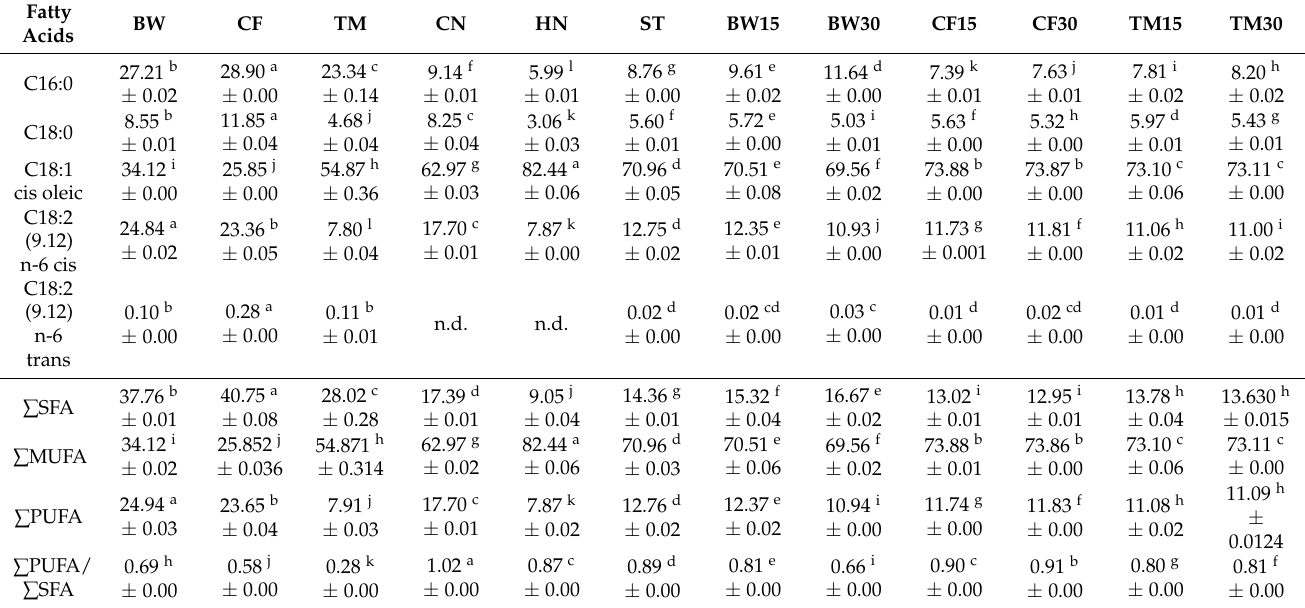
Table 4. Fatty acid profile of nut bars’ raw materials and enriched products (g/100